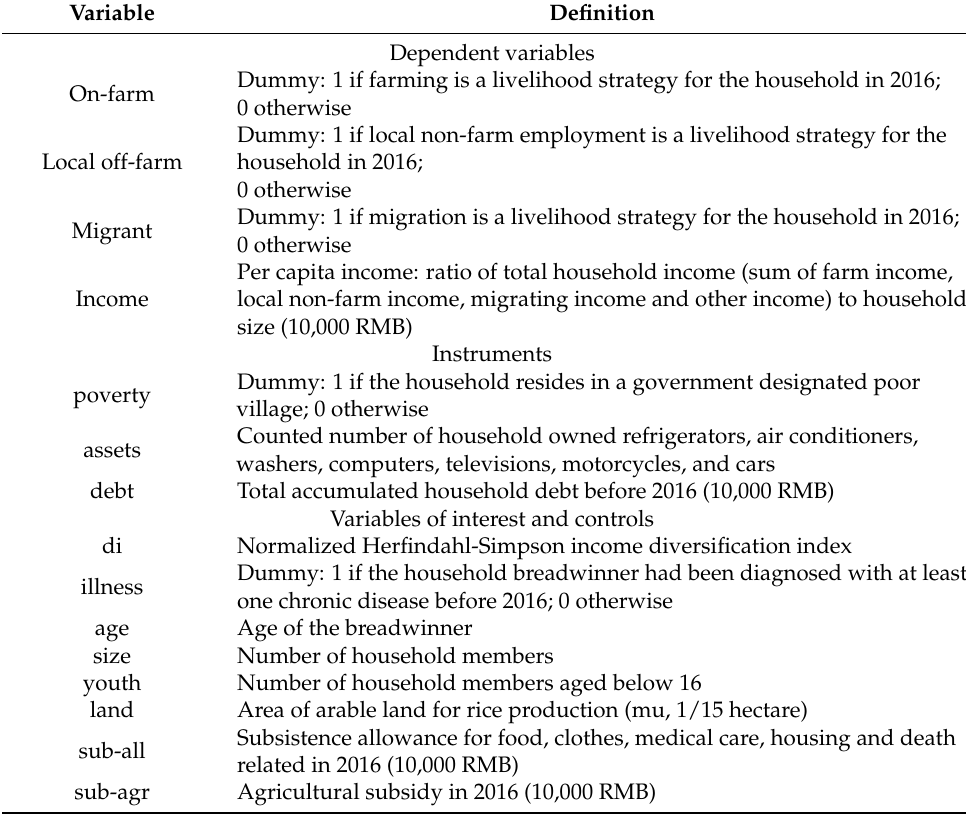
Table 1. Variables used in model